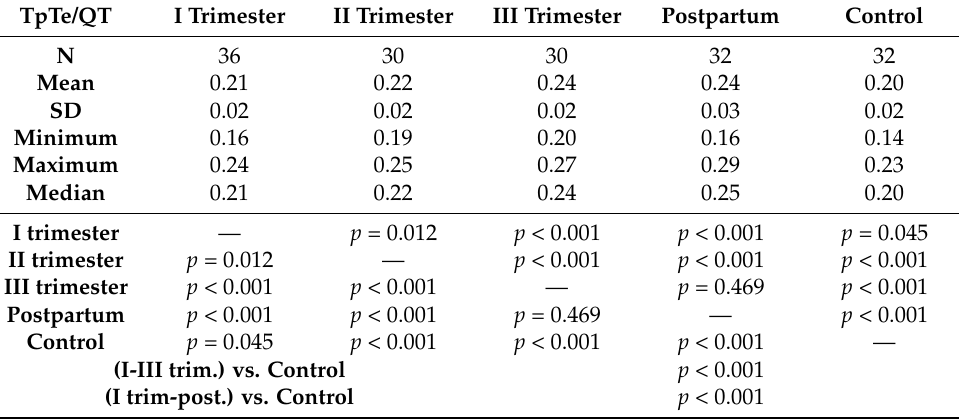
Figure 5. Changes in the TpTe/QT ratio in the study and control group. Table 3. TpTe/QT ratio in the 1st, 2nd, and 3rd trimester of pregnancy, in the puerperium and in the control